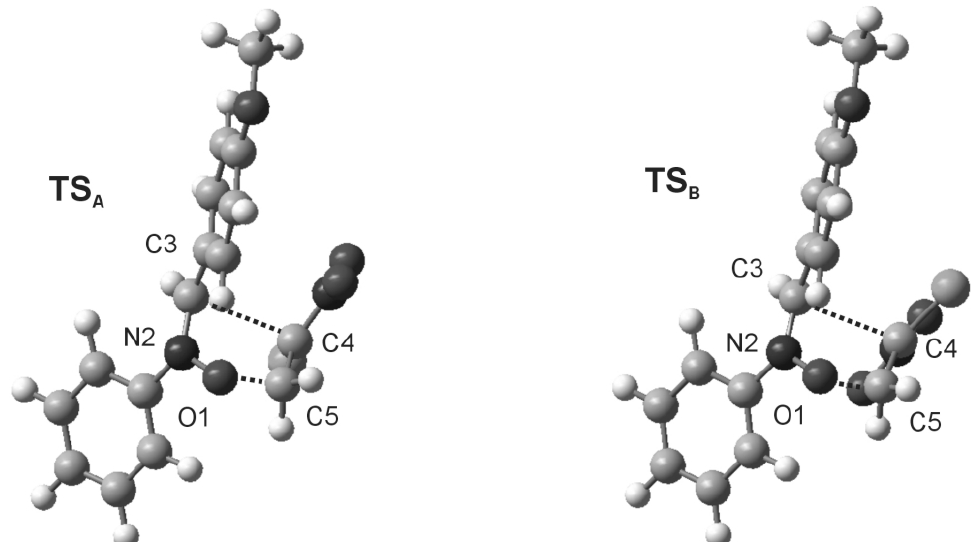
Figure 6. Views of transition complexes for [2+3] cycloaddition reaction 1-chloro-1-nitroethene 1 and (Z)-C-(p-methoxyphenyl)-N-phenylnitrone 2a in chloroform according to B3LYP/6-31G(d) (PCM) calculations (298